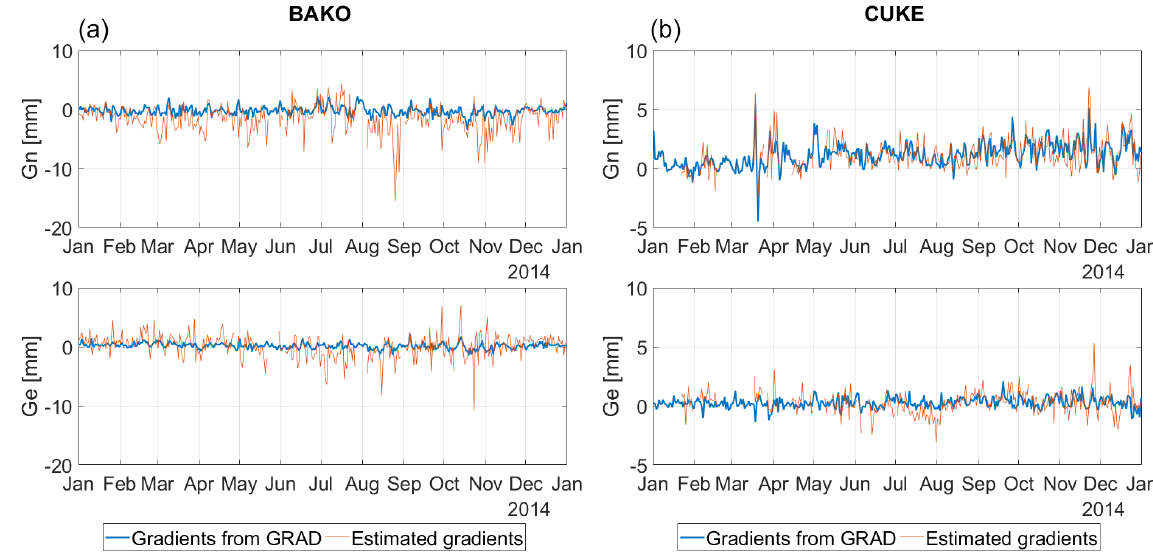
Figure 10. Comparison of gradients from GRAD with the estimated gradients at site BAKO and